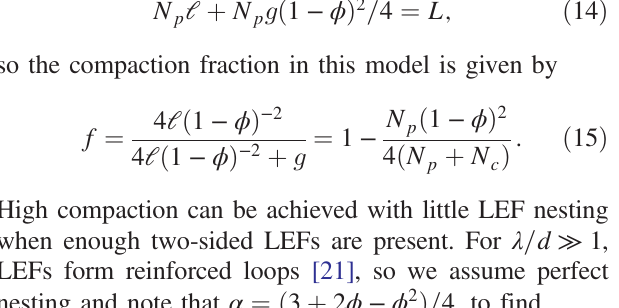
=N N =N ), LEFs per loop [ ð N ], g p p þ c Þ p 0 ) for =k s u ¼ → ∞ ) for (effec- =k s u